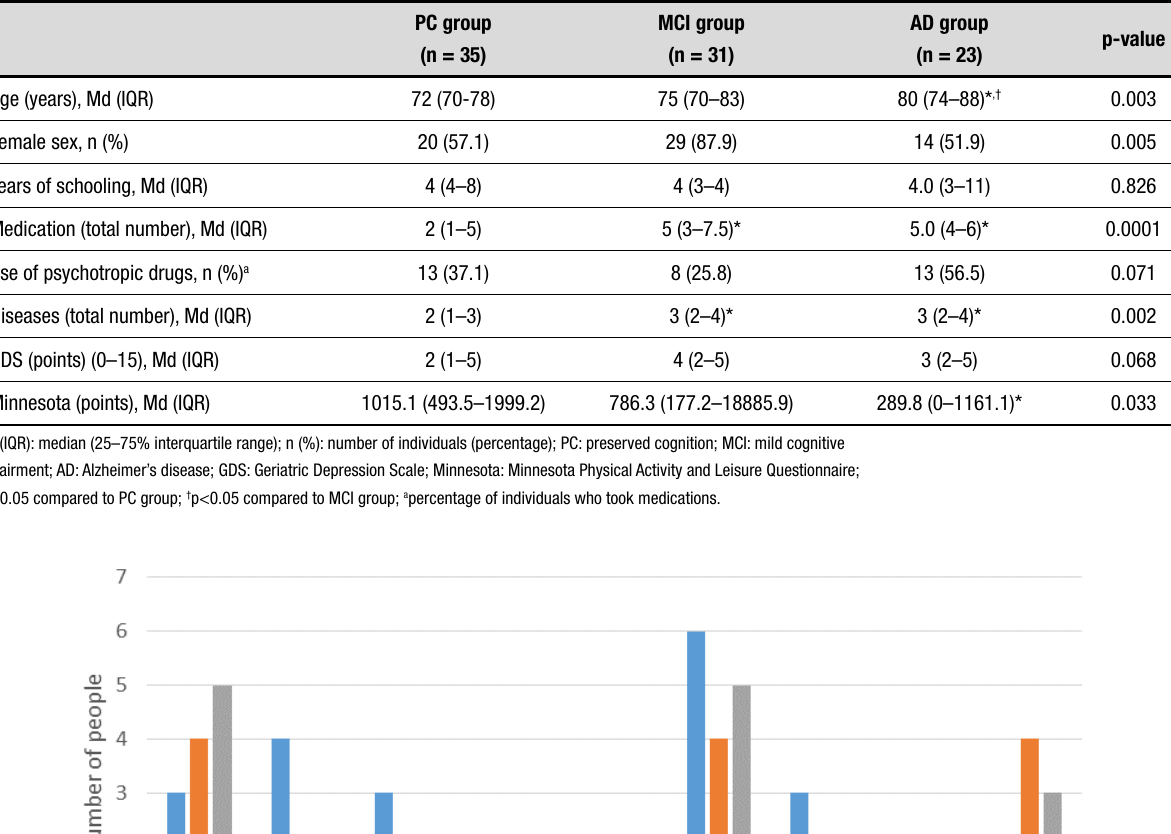
Table 1. Characteristics of sample at